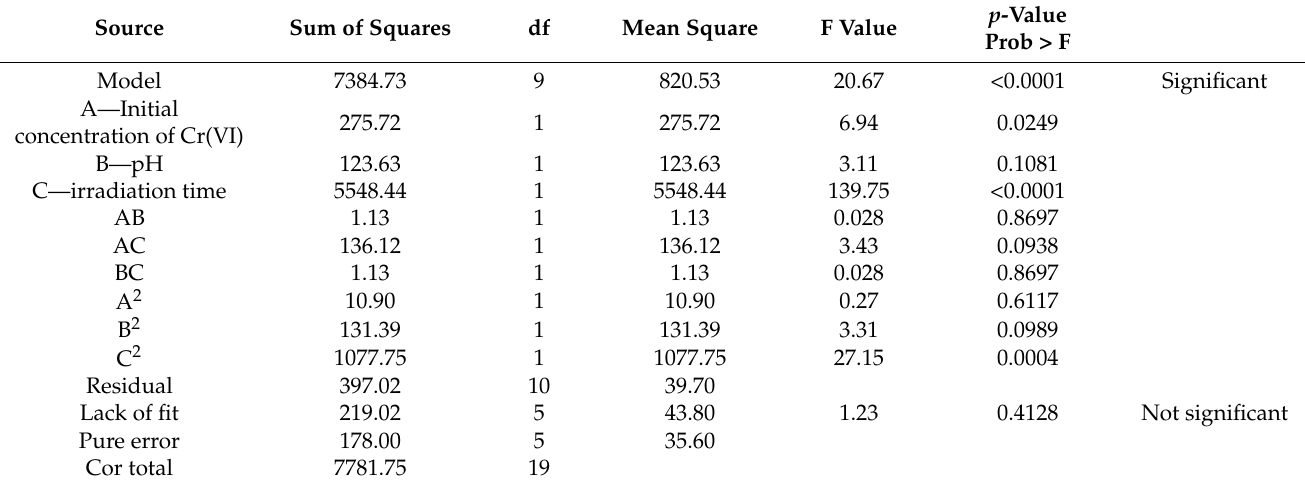
Table 2. ANOVA for response surface quadratic